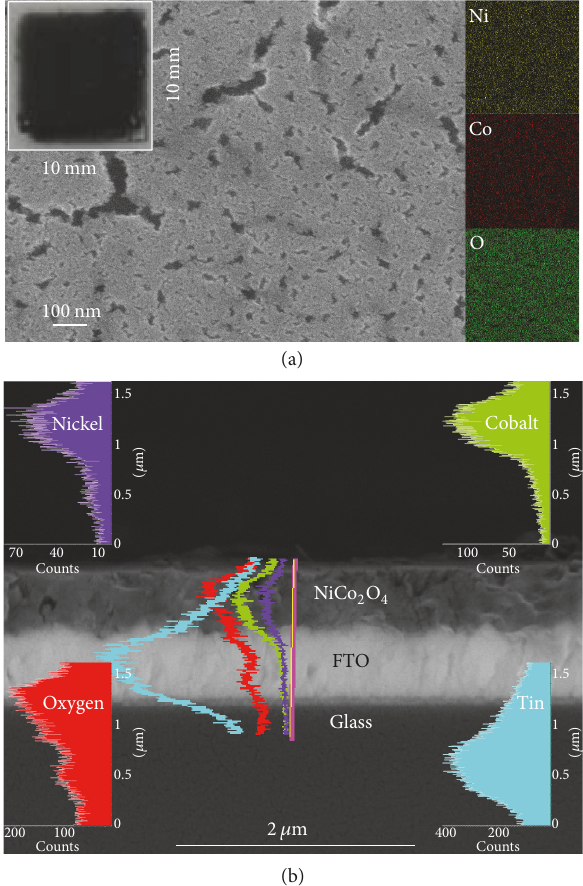
Figure 3: (a) SEM micrograph using secondary-electron mode and elemental chemical mapping of the film surface (upper left inset is a photograph of the deposited sample) and (b) cross-sectional SEM image using the low-angle back-scattered electron mode and EDS line